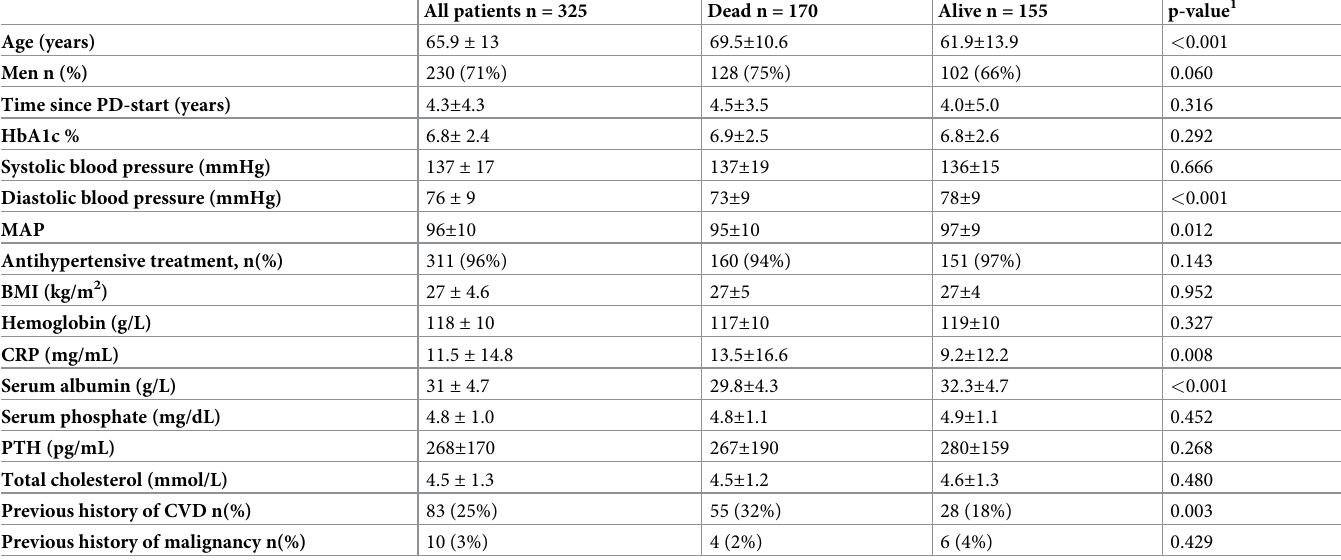
Table 1. Clinical and biochemical characteristics in the study population (n = 325) of diabetic patients receiving PD treatment.